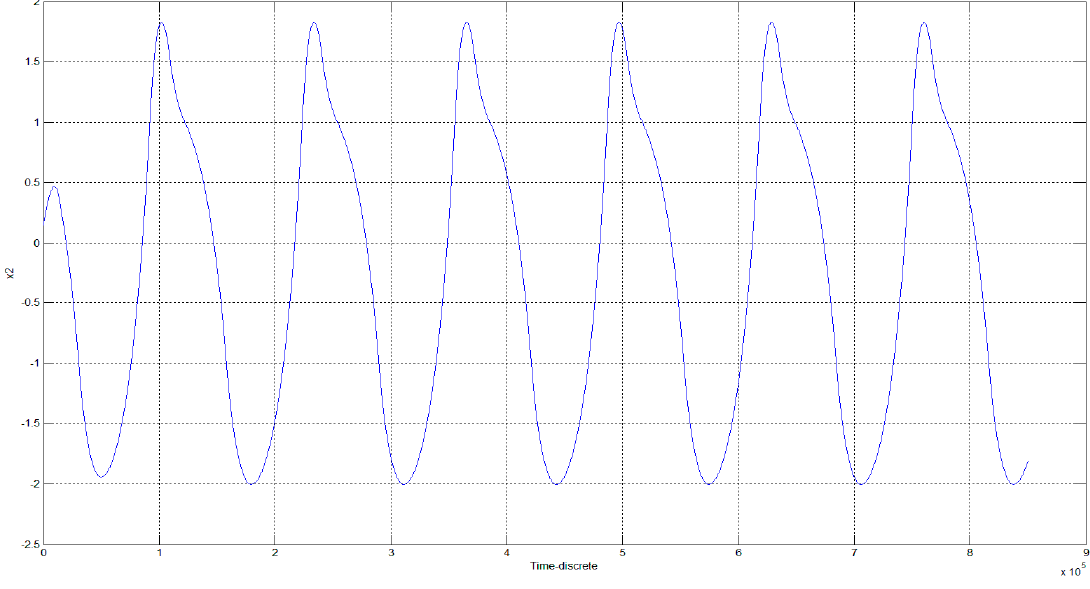
Figure 7. The dynamic of the x 2 variable of the proposed reaction-diffusion (RD) model reported in Equation (2).